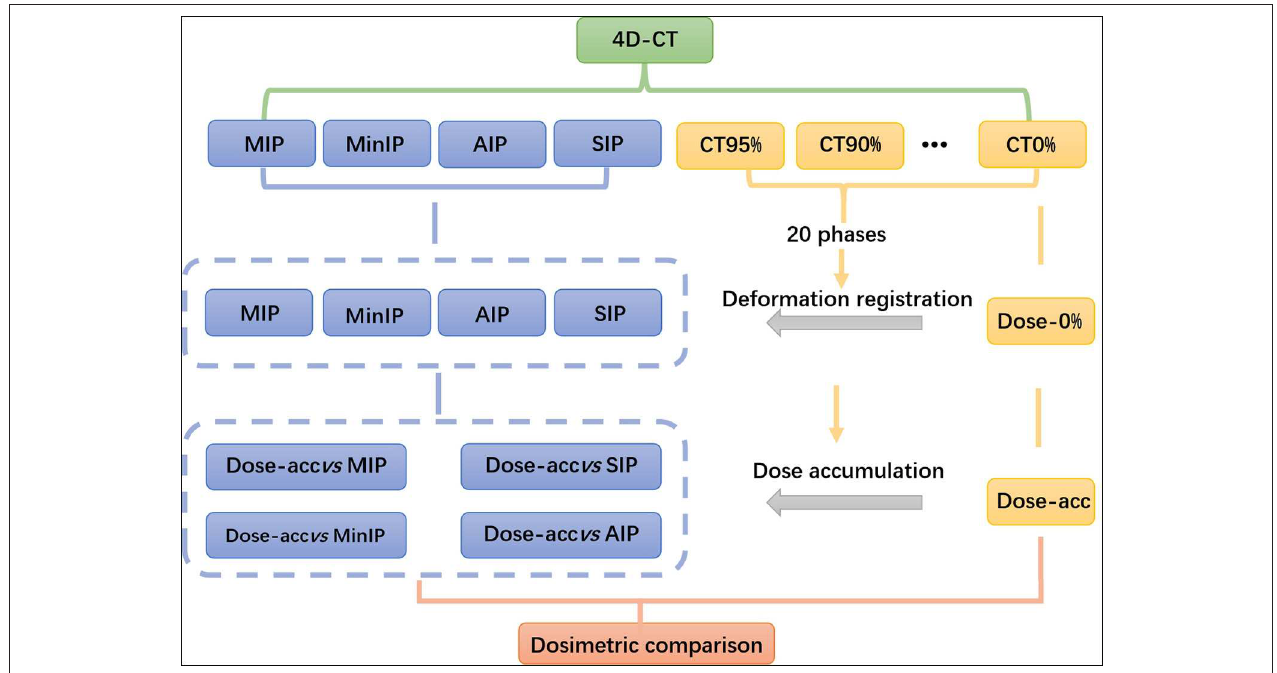
FIGURE 2 | Dosimetric comparison flow